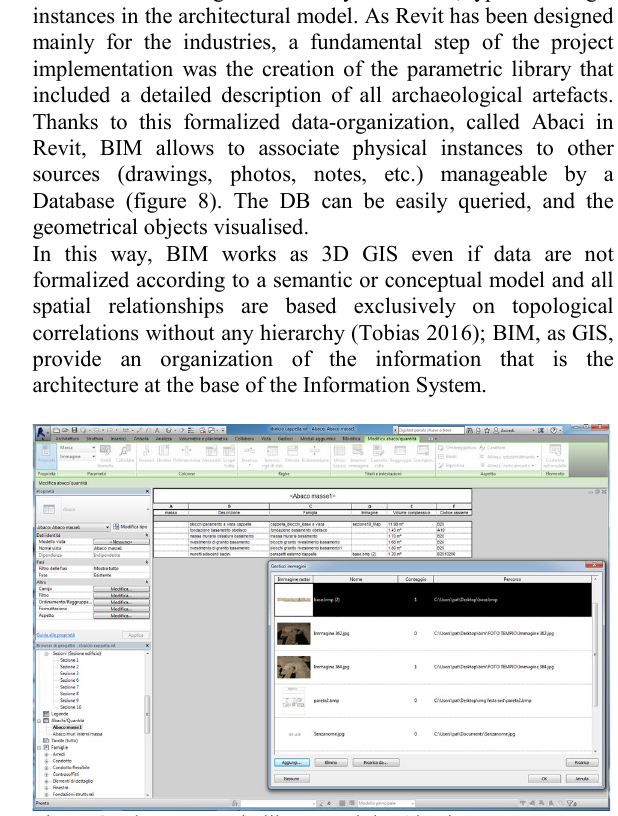
Figure 8: The parametric library and the